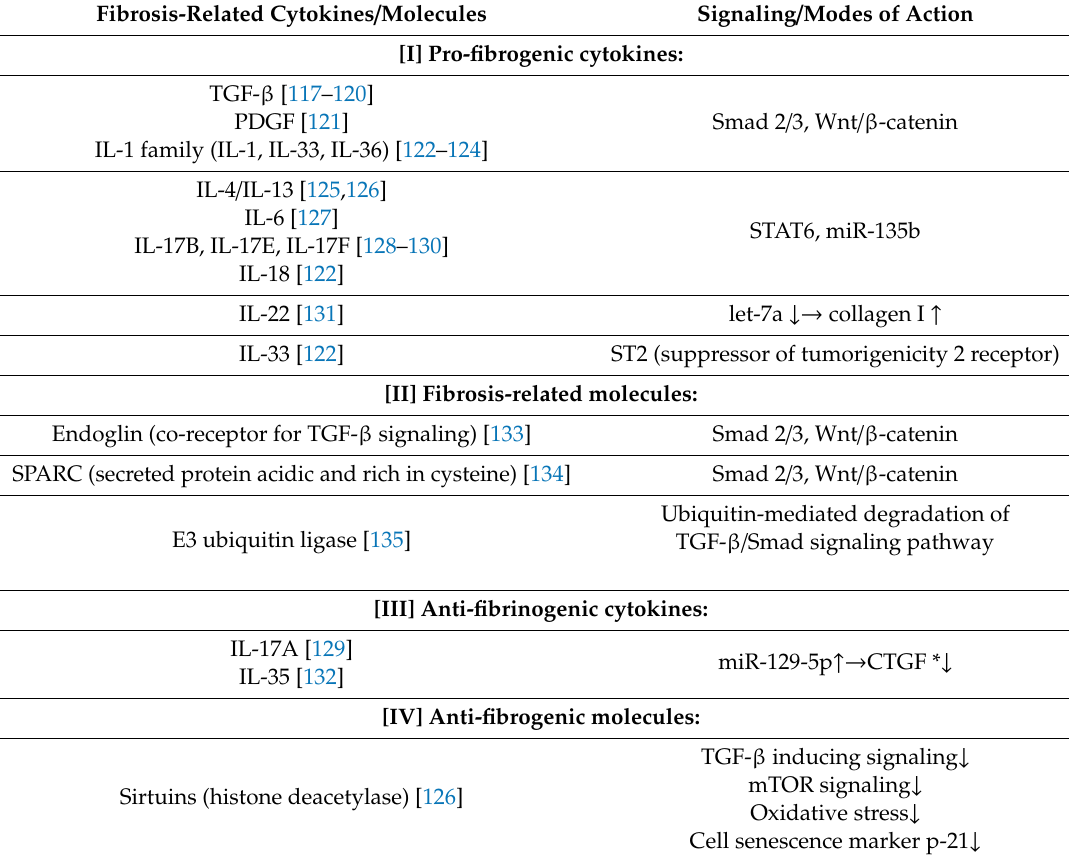
Table 2. The fibrosis-related cytokines / growth factors / molecules, and their signaling / modes of action in patients with systemic